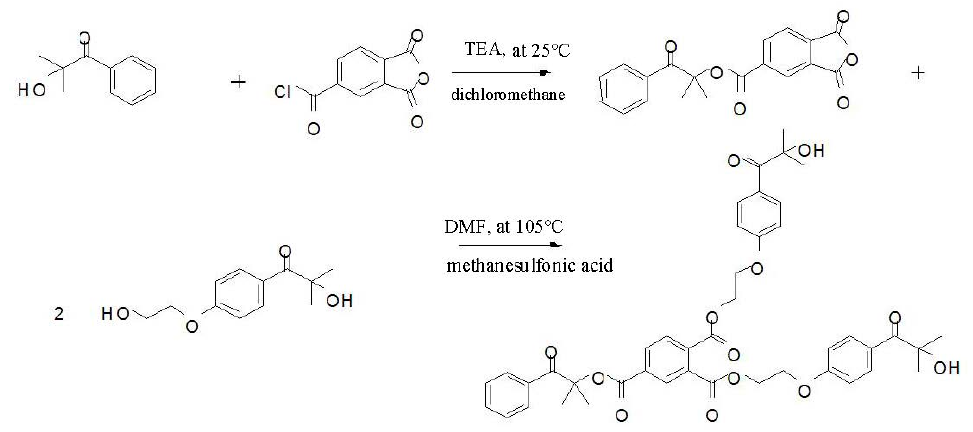
Figure 1. Synthesis route of HTH.